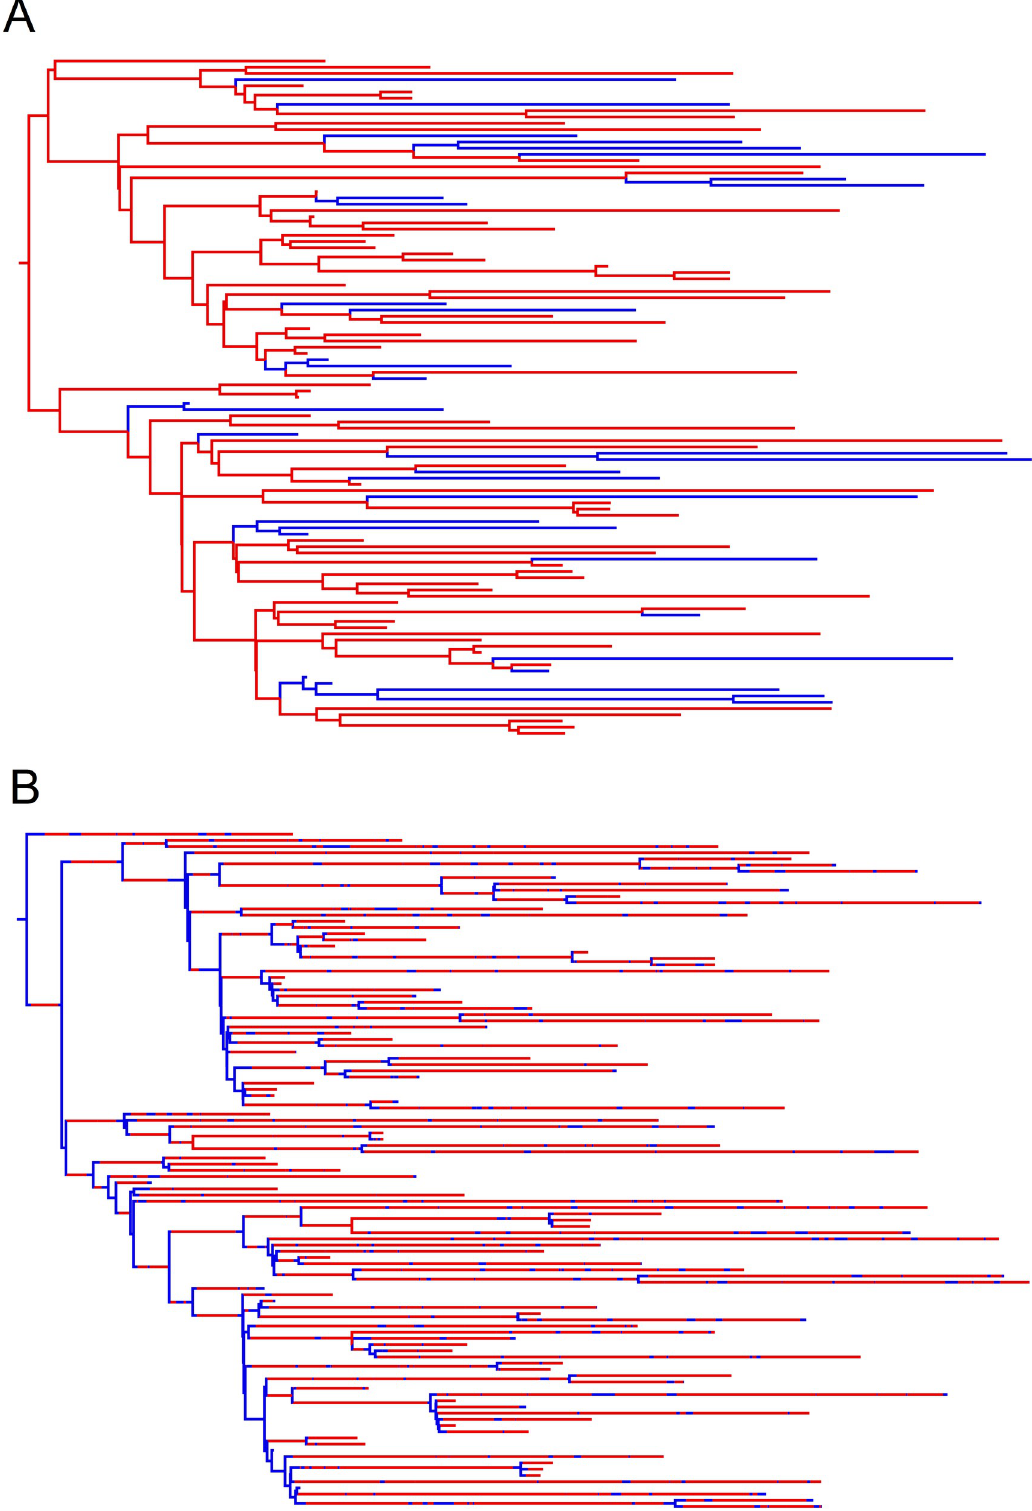
Fig 18. Maximum clade credibility tree produced by the DTA model (A) and maximum a posteriori tree produced by the SC model (B), based on 109 DT160 isolates.